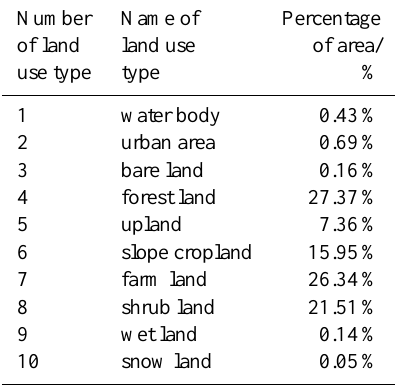
Table 2. The land use information in the earthquake-affected